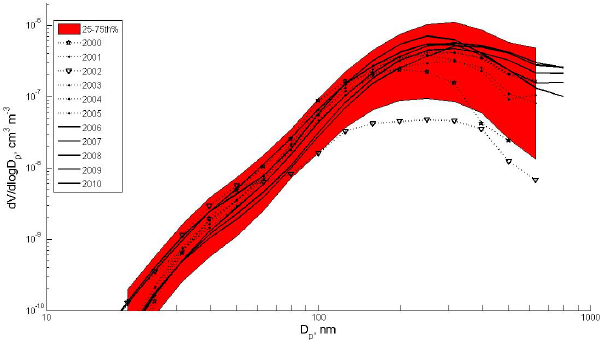
Fig. 3. Percentile range of aerosol volume size distributions col- lected during 2000–2010 (red surface) and corresponding annual median aerosol number size distributions (black lines); pre-2006 data as dashed lines and post-2006 data as solid lines. Units in dV/dlog D p , cm 3 m − 3